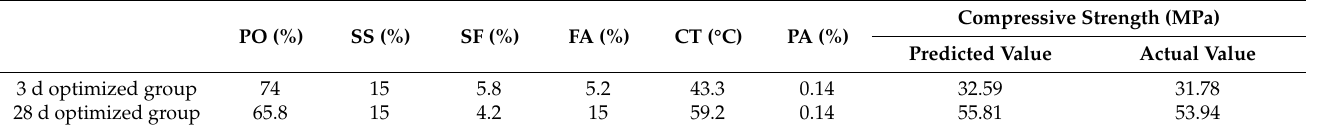
Table 5. Measured and predicted values of the SCGS’s